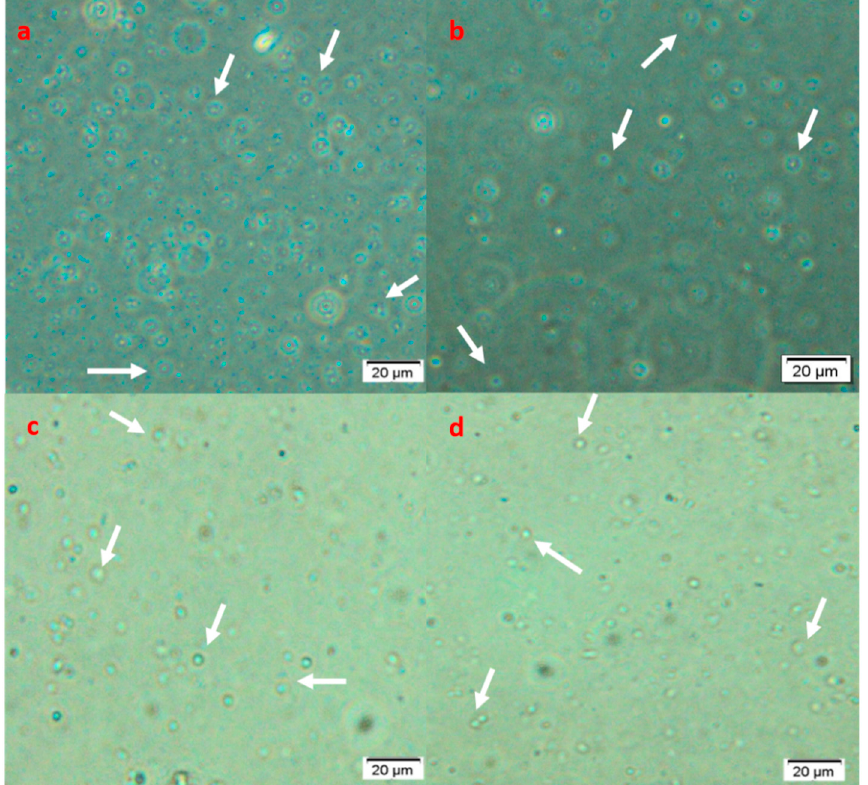
Figure 3. Inverted light microscopy in phase-contrast mode of: ( a ) blank liposomes; ( b ) loaded liposomes with 15% AA; ( c ) loaded liposomes with 20% AA; ( d ) loaded liposomes with 25% AA. White arrows indicate homogeneous dispersion of spherical, stable liposomes with and without AA included.